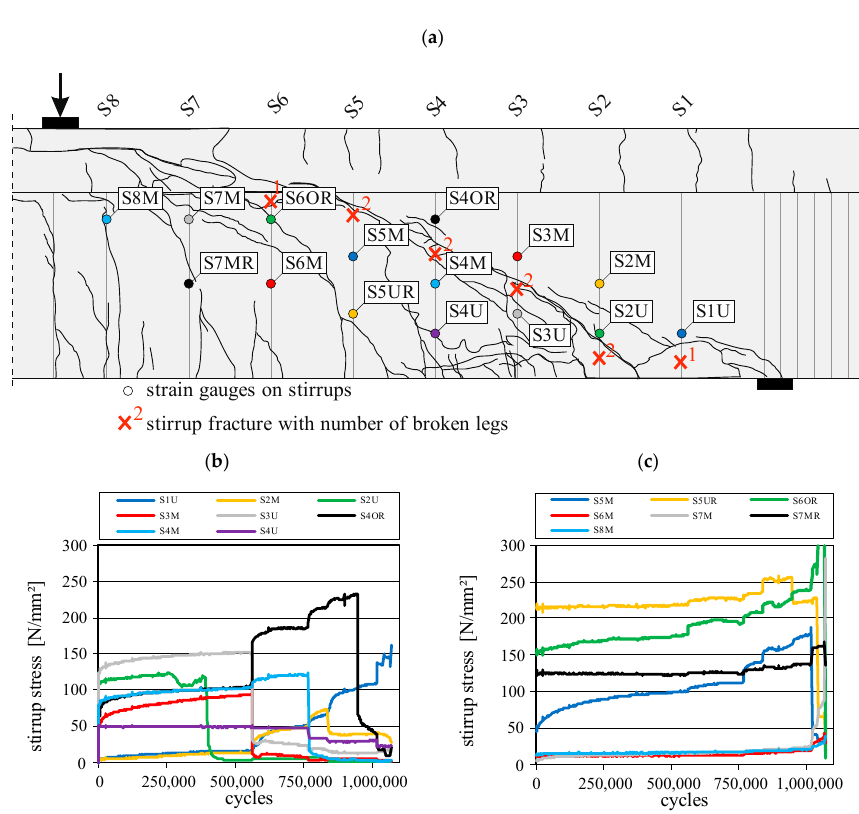
Figure 5. Test T-33-2a: ( a ) Crack pattern after first part of testing in the shear span with strain gauges on stirrups, documented locations of stirrup fatigue failures and number of broken legs; ( b , c ) Stirrup stresses under maximum force for stirrups S1 to S4 and S5 to S8, respectively.